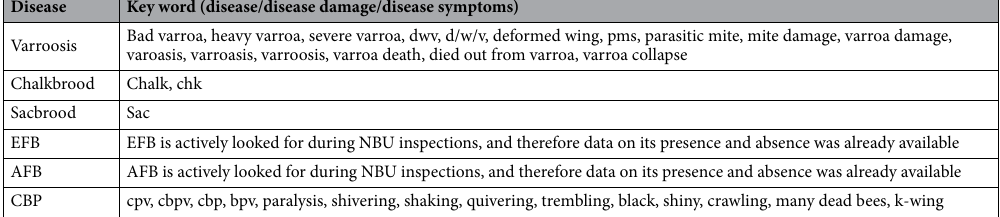
Table 1. Keywords used to assign diseases cases from honey bee health visit